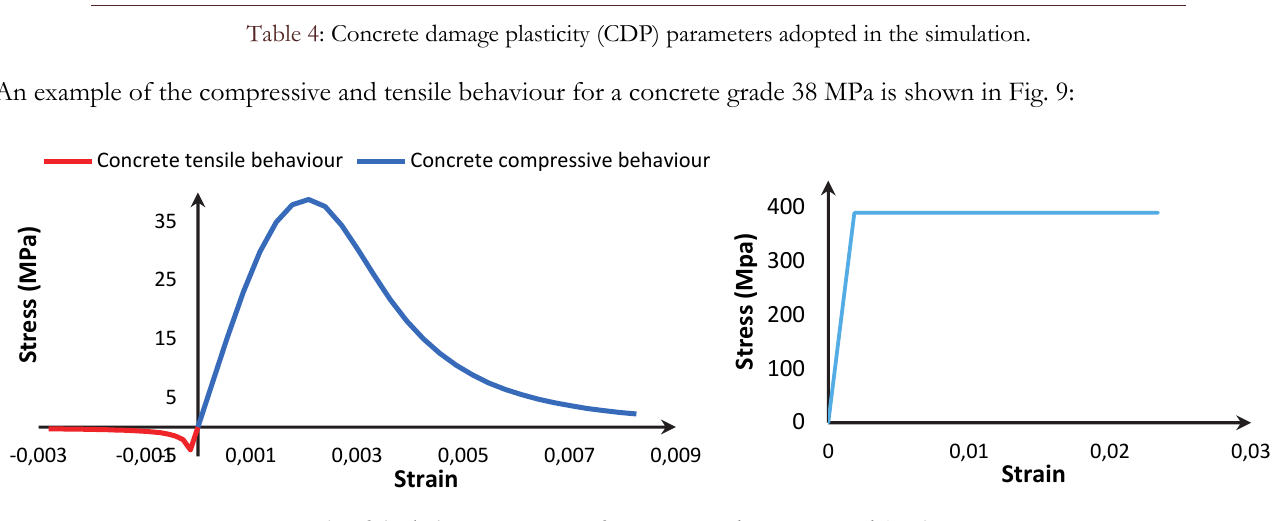
Figure 9: Example of the behaviour curves of concrete grade 38 MPa and Steel stress-strain curve.